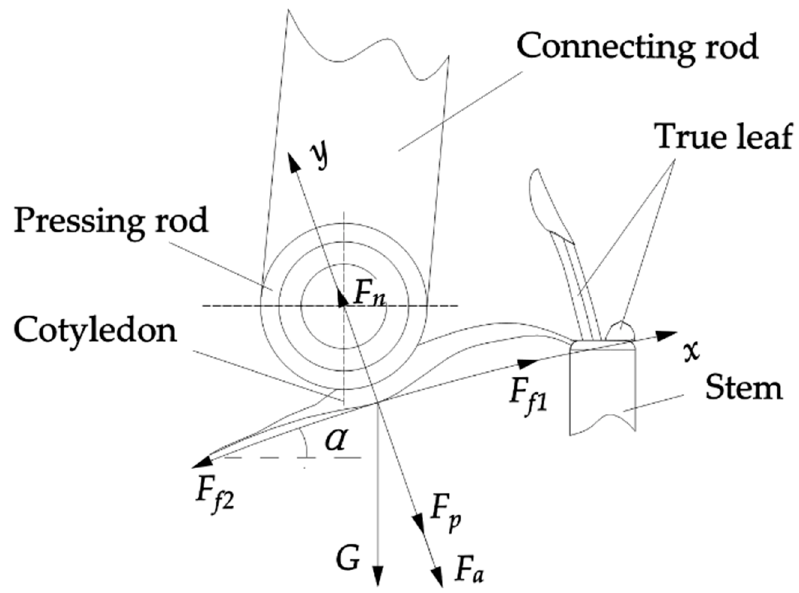
Figure 6. 3D model of seedling pressing mechanism. 1. Connecting block. 2. Connecting rod. 3. Spring. 4. Bearing. 5. Shaft. 6. Bearing retaining ring. 7. Seedling pressing rod.